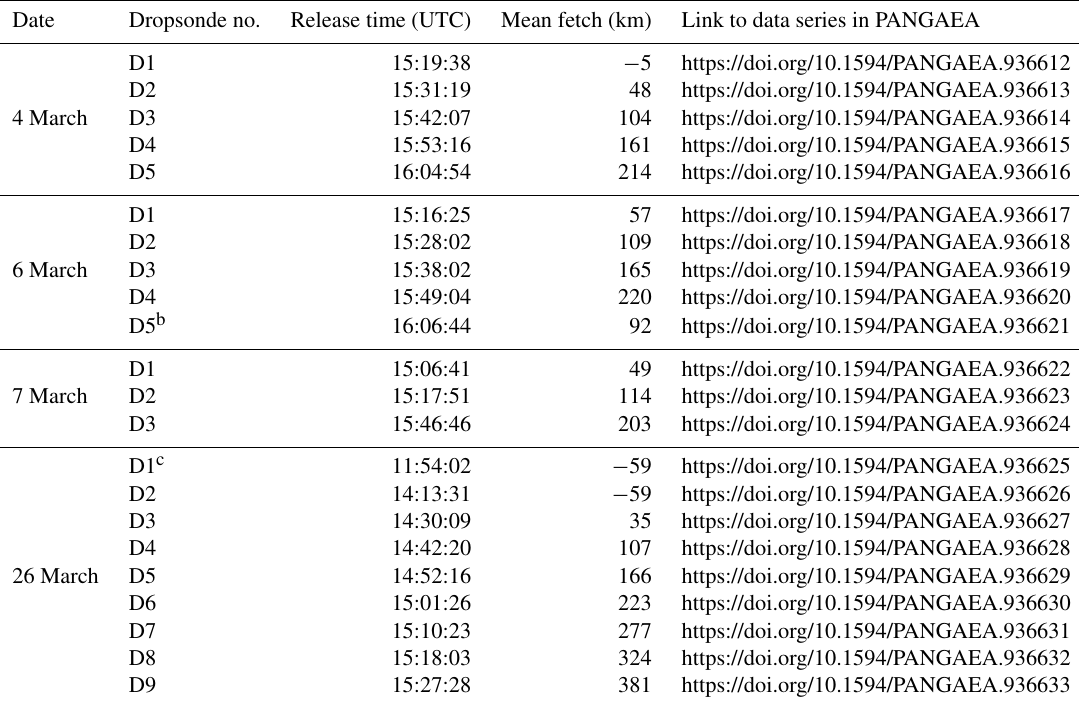
Table 2. Overview of all dropsondes released on 4, 6, 7, and 26 March 2013.